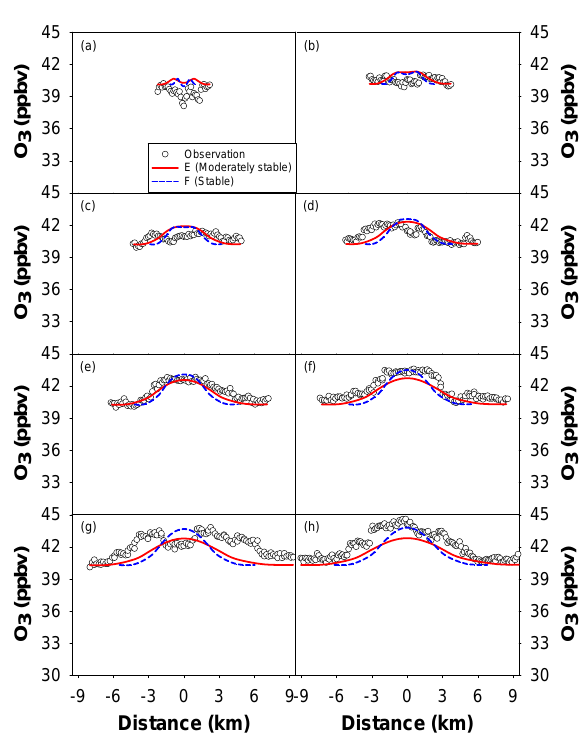
Fig. 6. As Fig. 4, except for